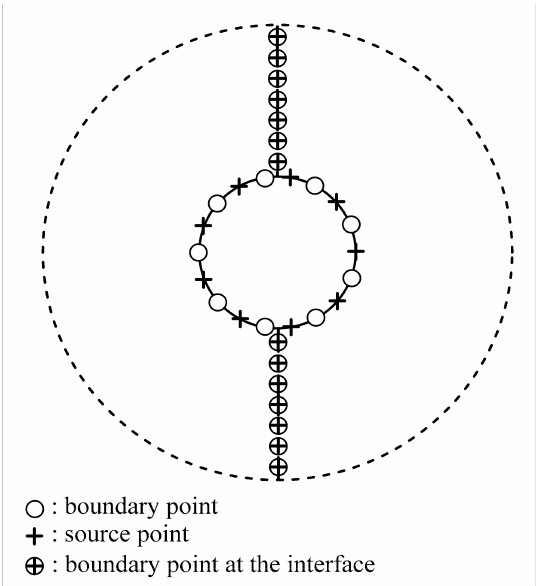
Figure 20. Configuration of sub-boundaries.